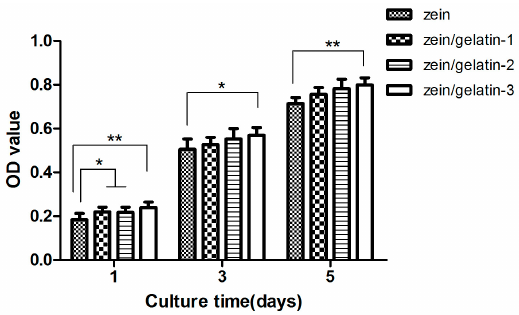
Figure 6. Characterization of cell proliferation on electrospun membrane containing zein with different gelatin ratios at different times. (*), and (**) represent a statistical significance of p < 0.05 and p < 0.01, respectively.